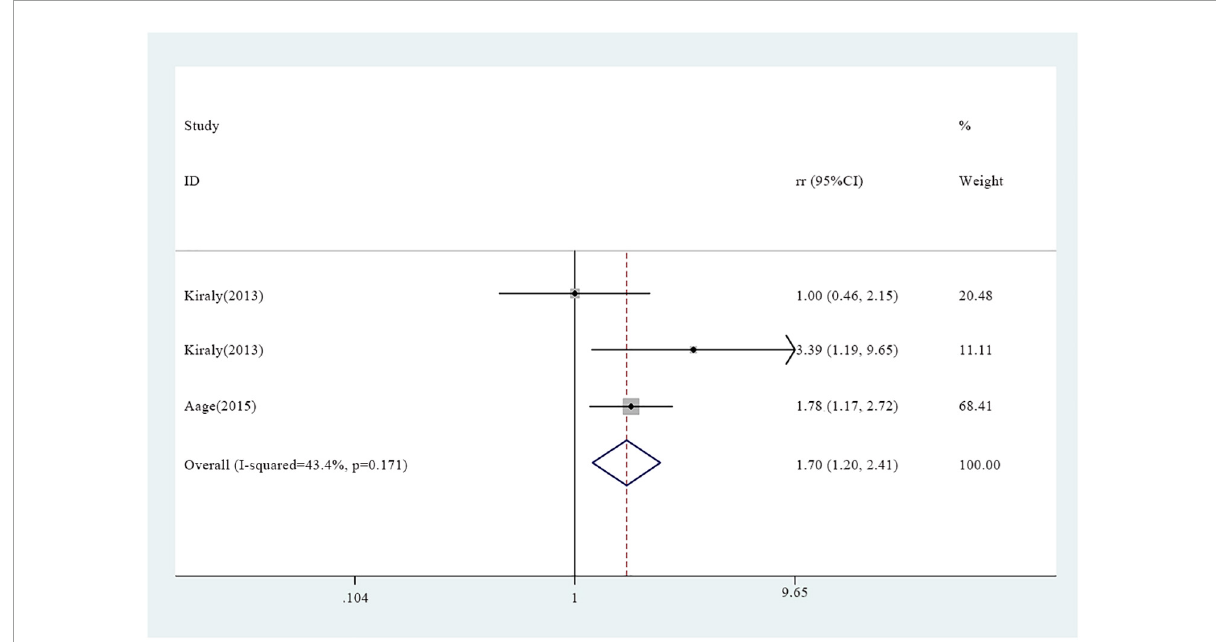
FIGURE3 Association between vitamin A supplementation and rapid atopy among young female participants.